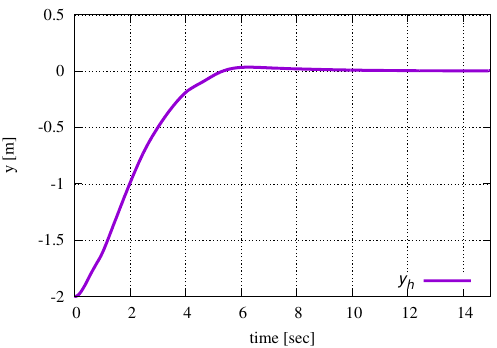
Figure 30. Case 3: Time variation of the y coordinate of the head